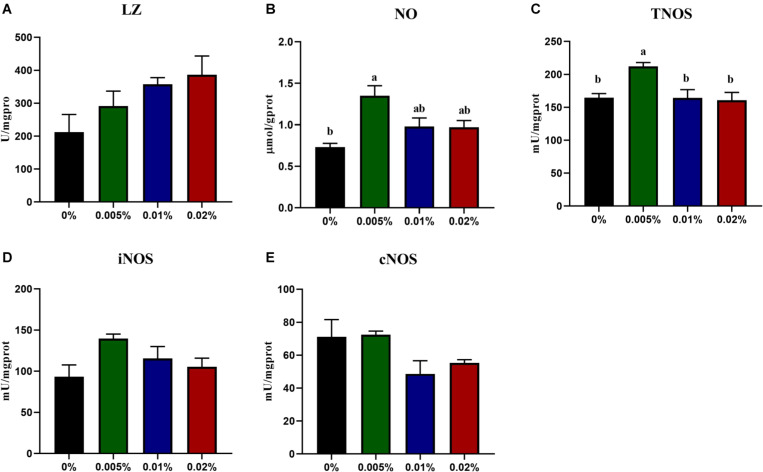
The specific activity of LZ (A), the content of NO (B), specific activity of TNOS (C), iNOS (D) and cNOS (E) in the visceral mass of large yellow croaker larvae. LZ, lysozyme; NO, nitric oxide; TNOS, total nitric oxide synthase. Data are presented as means ± S.E.M. Columns sharing the same superscript letter or absence of superscripts are not significantly different determined by Tukey’s test (P > 0.05). S.E.M.: standard error of means.